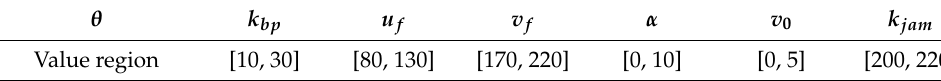
Table 1. Value regions for the calibration